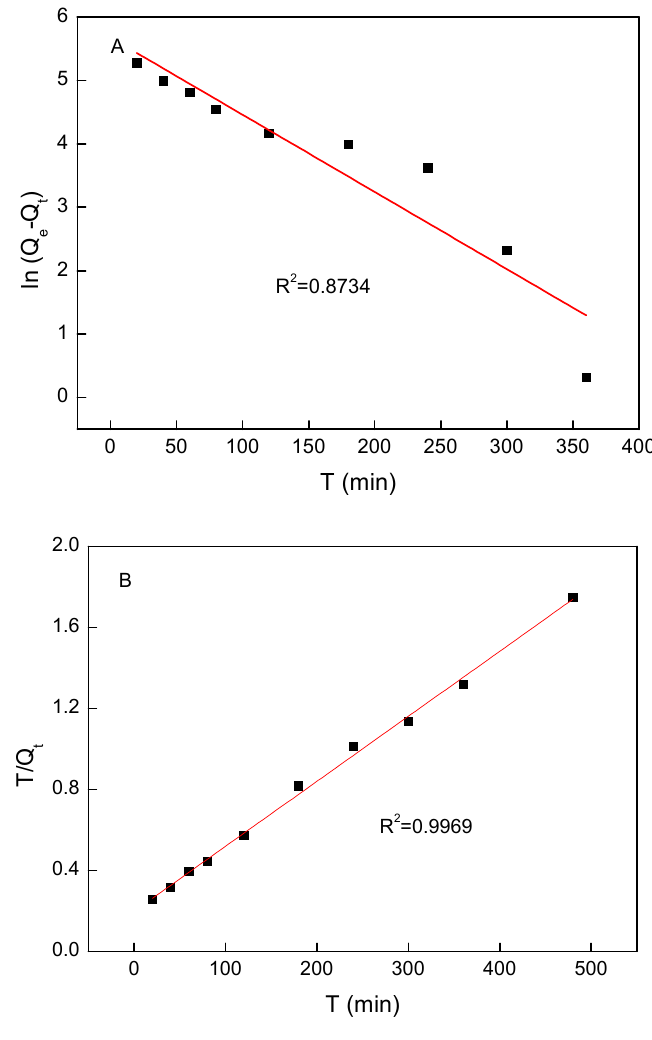
Figure 5. Pseudo-first-order kinetic model fitting ( A ) and pseudo-second-order kinetic model fitting Figure 5. Pseudo ‐ first ‐ order kinetic model fitting ( A ) and pseudo ‐ second ‐ order kinetic model fitting ( B ) of the adsorption process for PIL-3 toward Zn 2+ . ( B ) of the adsorption process for PIL ‐ 3 toward Zn 2+ . Table 3. Adsorption kinetic parameters of Zn 2+ on Table 3. Adsorption kinetic parameters of Zn 2+ on PIL ‐ 3.